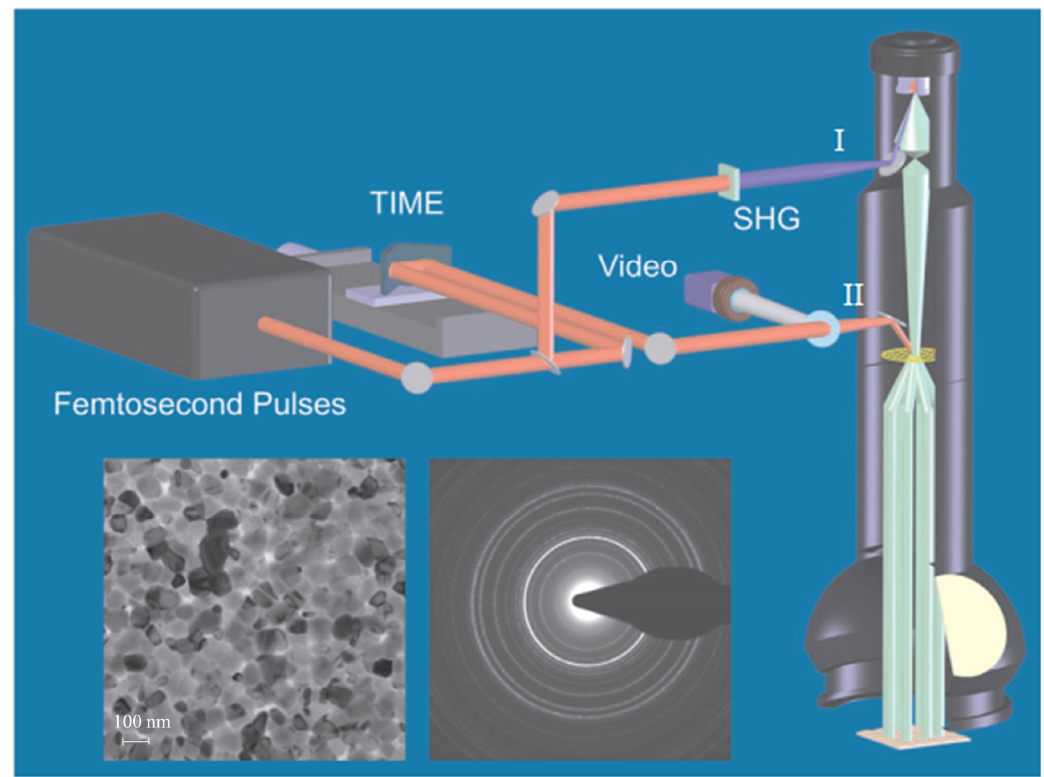
Figure 1. (Color online) Schematic of an ultrafast transmission electron microscope [38]. A commercially available transmission electron microscope that was originally designed for continuous operation with a thermionic cathode can be taken as a basis for creating such a setup. In order to adapt the industrial apparatus to UED requirements, it is necessary to ensure pulsed laser excitation of the sample (marked with symbol II), as well as the delivery of the laser radiation to the photocathode (marked with symbol I) to generate an ultrashort pulsed photoelectron beam. (Adapted from work in [38] with minor changes. Copyright (2006) National Academy of Sciences.)